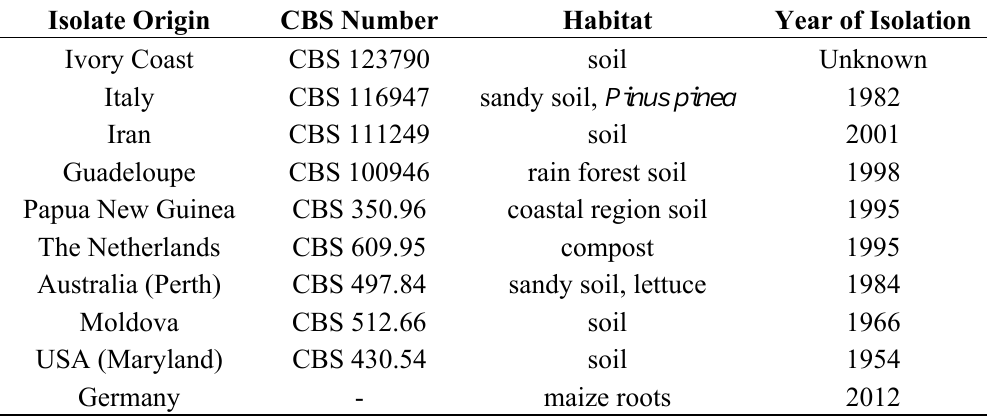
Table 2. CBS numbers of the utilized T. virens strains with additional information retrieved from the CBS